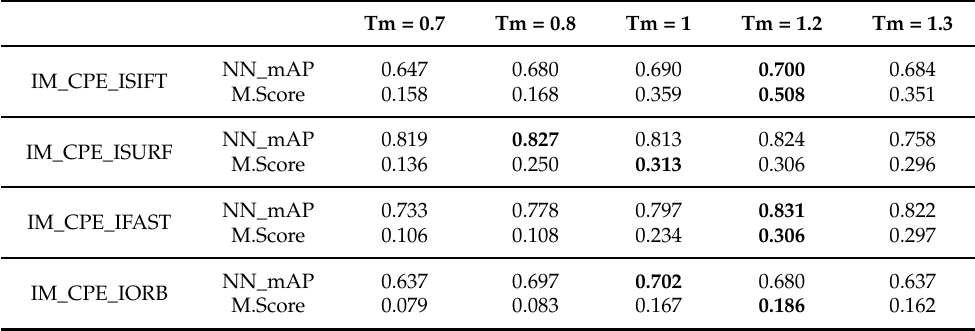
Table 2. Comparison of results of IM_CPE using four kinds of key points with various T M s in terms of NN_mAP and M.Score in ‘desk’ sequence.